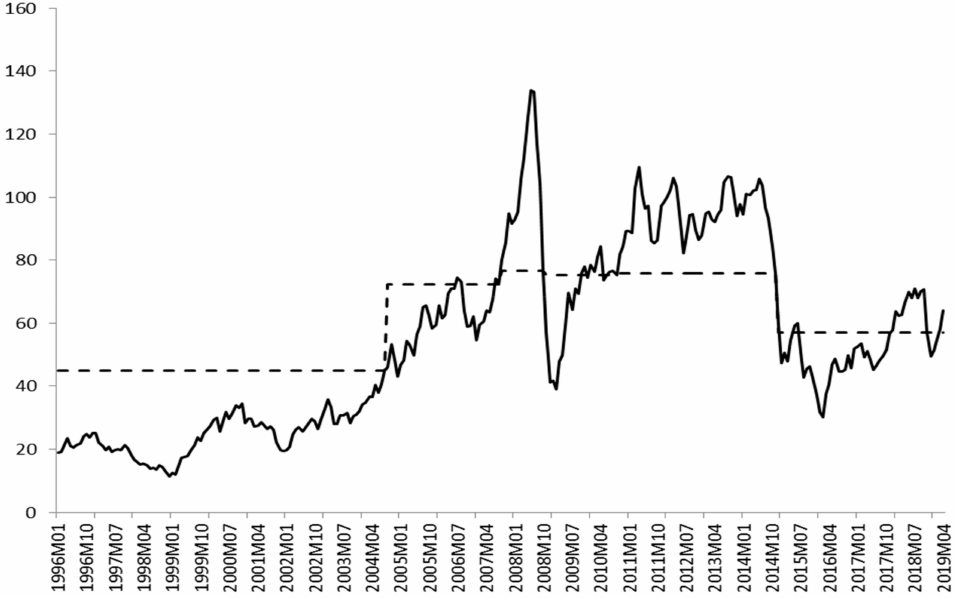
Figure 3. WTI crude oil prices in